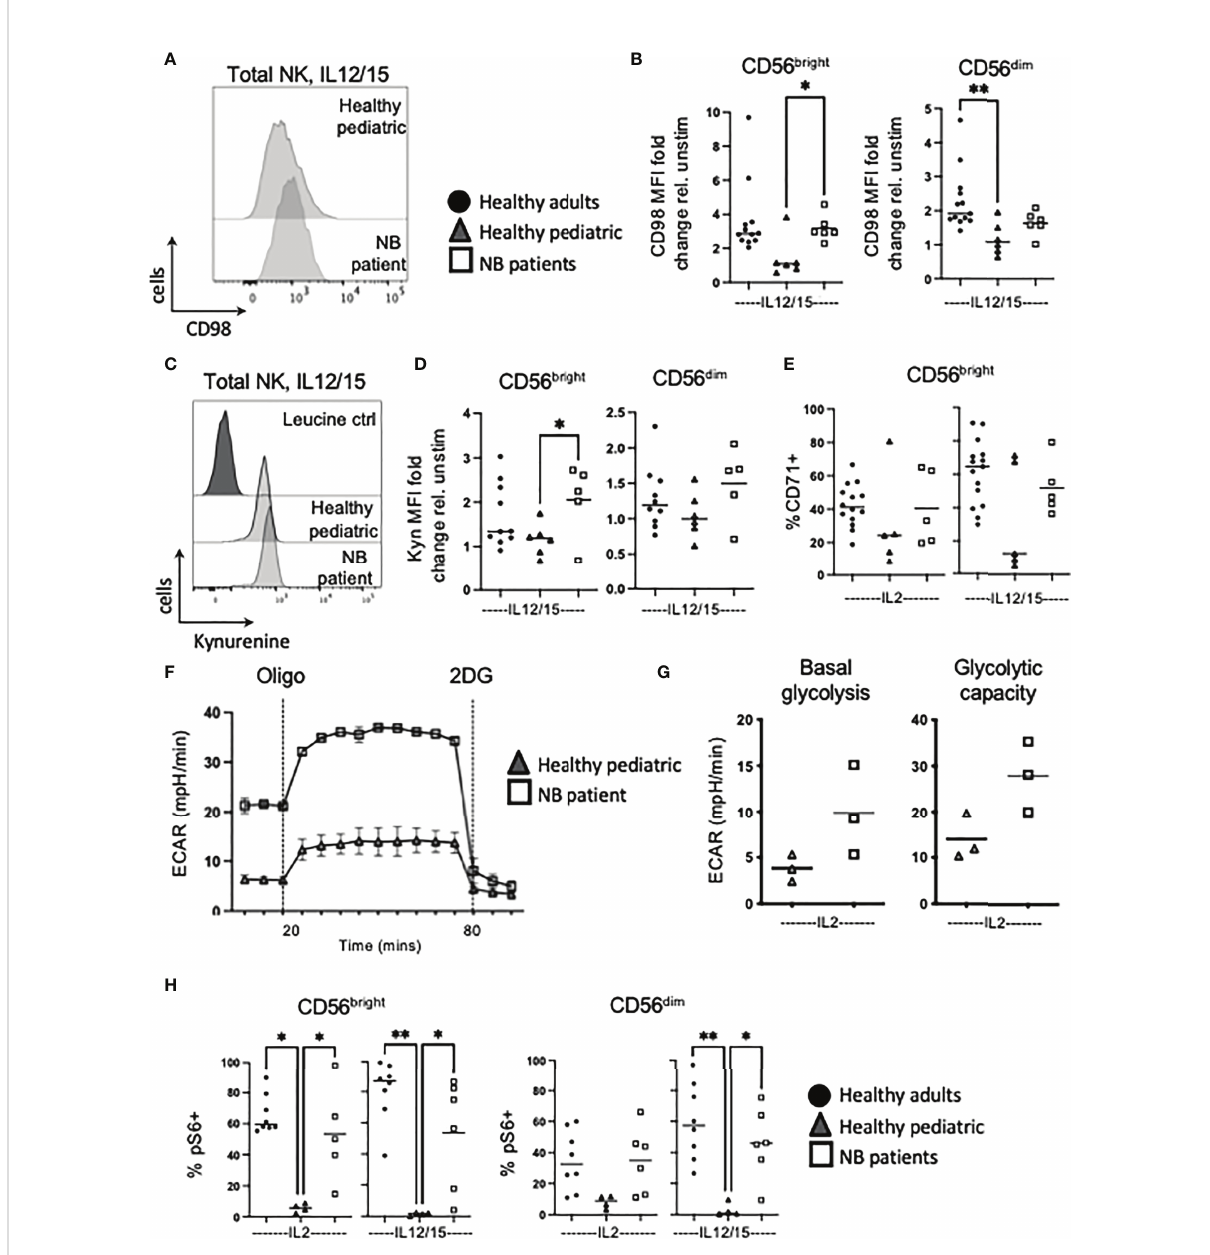
FIGURE 3 NK cells from NB patients have heightened metabolic responses and are glycolytic. PBMC were isolated from fresh blood of healthy adult donors, healthy pediatric donors and NB patients. Cells were stimulated with IL2 (500 IU/mL) or IL12 (30 ng/mL) and IL15 (100 ng/mL) at 37°C for 18 hours where indicated. (A, B) Cells were stained for CD98 and analyzed by fl ow cytometry. (C, D) Cells were incubated with kynurenine (200 m M) and analysed by fl ow cytometry. Representative histograms are shown in (C) and dots represent individual donors and horizontal bars show the mean in (D) . (E) Cells were stained for CD71 and analyzed by fl ow cytometry. (F, G) Seahorse analysis of puri fi ed NK cells from healthy pediatric donors and NB patients was performed on the XFp extracellular fl ux analyzer. (H) Cells were stained for pS6 and analyzed by fl ow cytometry. Dots represent individual donors and horizontal bars show the mean, N=3-15. Samples were compared using the Two-way ANOVA test or Student ’ s t-test, *p<0.05,